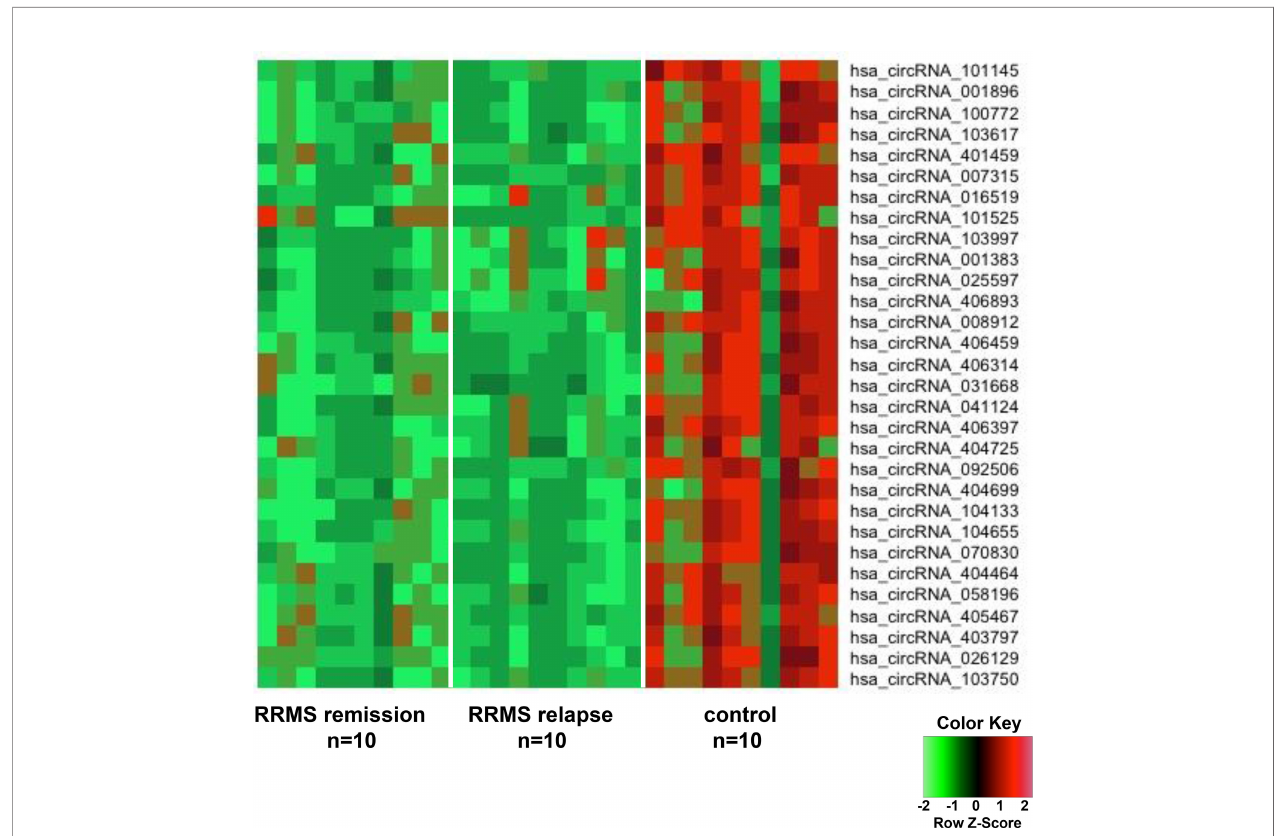
Figure 1 . The list of the 10 most signi fi cant circRNAs downregulated in RRMS is presented in Table 2